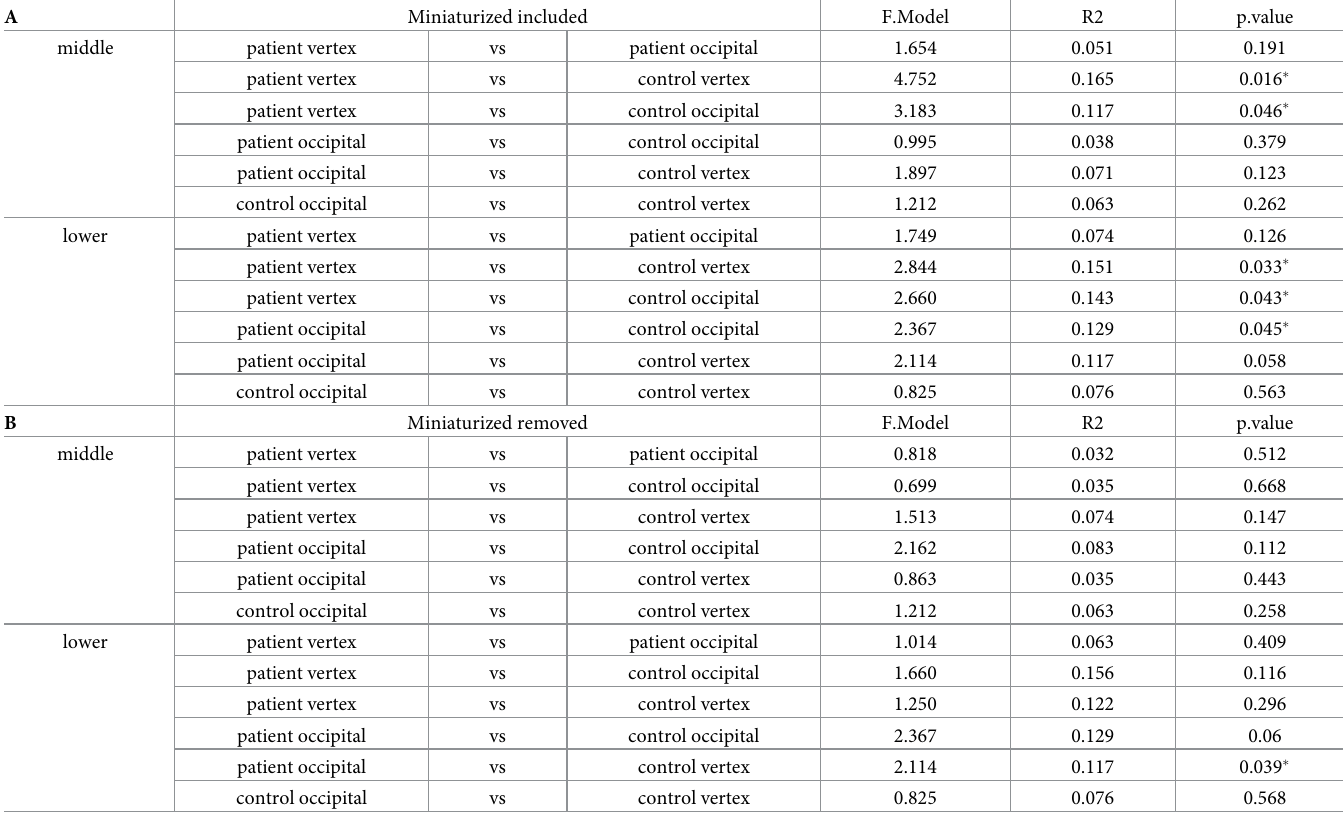
Table 2. Pairwise comparisons for PERMANOVA between samples across different compartments, regions and AGA